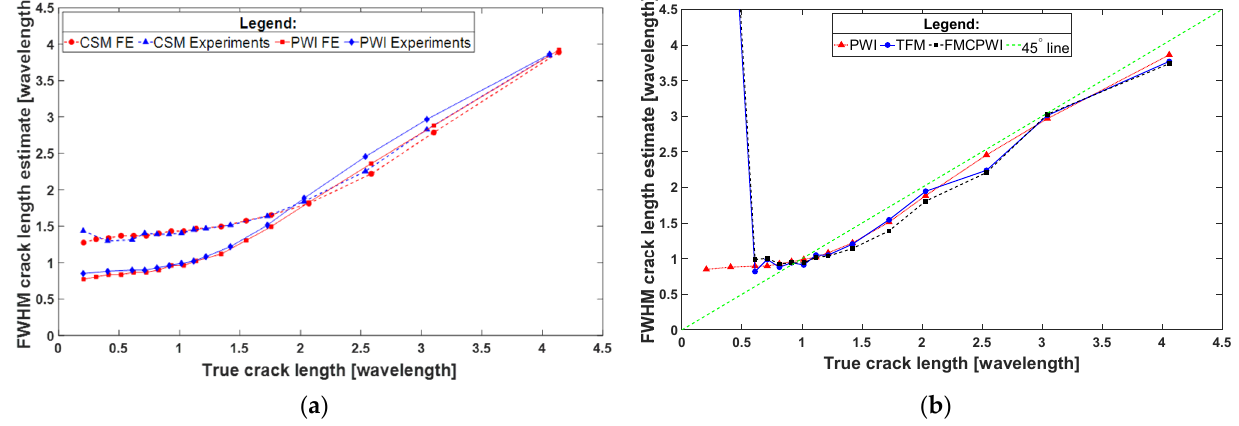
Figure 11. Comparison of FWHM sizing capabilities of ( a ) PWI and CSM using experimental and FE results for 50% through thickness deep notch/crack, ( b ) PWI, TFM and FCPWI using experimental results for 50% through thickness deep